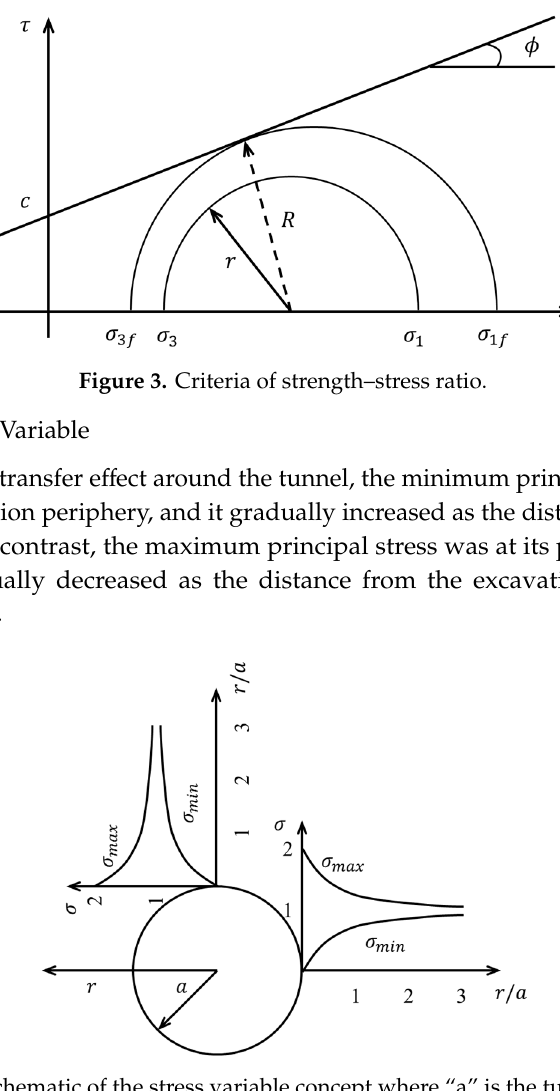
Figure 3. Criteria of strength–stress ratio.